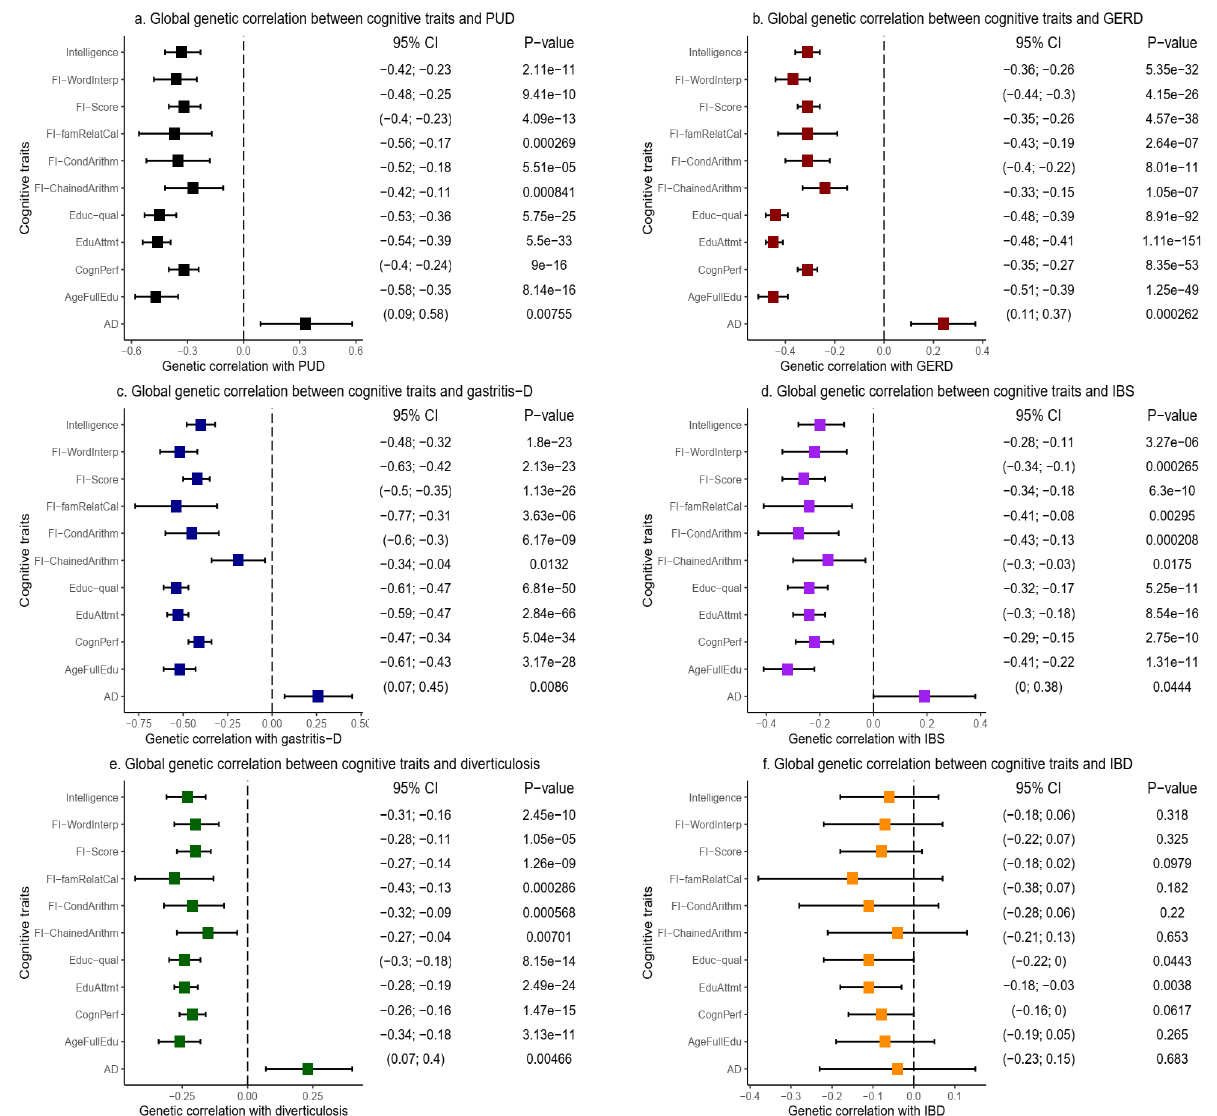
Figure 2. Global genetic correlation of cognitive traits and AD with GIT disorders using LDSC. AD: Alzheimer’s disease, IBS: irritable bowel syndrome, PUD: peptic ulcer disease, GERD: gastroesophageal reflux disease, IBD: inflammatory bowel disease, Gastritis-D: gastritis-duodenitis, AgeFullEdu: age completed full-time education, FI-ChainedArithm: fluid intelligence-chained arithmetic, FI-CondArithm: fluid intelligence-conditional arithmetic, FI-famRelatCal: fluid intelligence-family relationship calculation, FI-WordInterp: fluid intelligence-word interpolation, CognPerf: cognitive performance, Educ-qual: educational qualification, EduAttmt: educational attainment. GIT: gastrointestinal tract, LDSC: linkage disequilibrium score